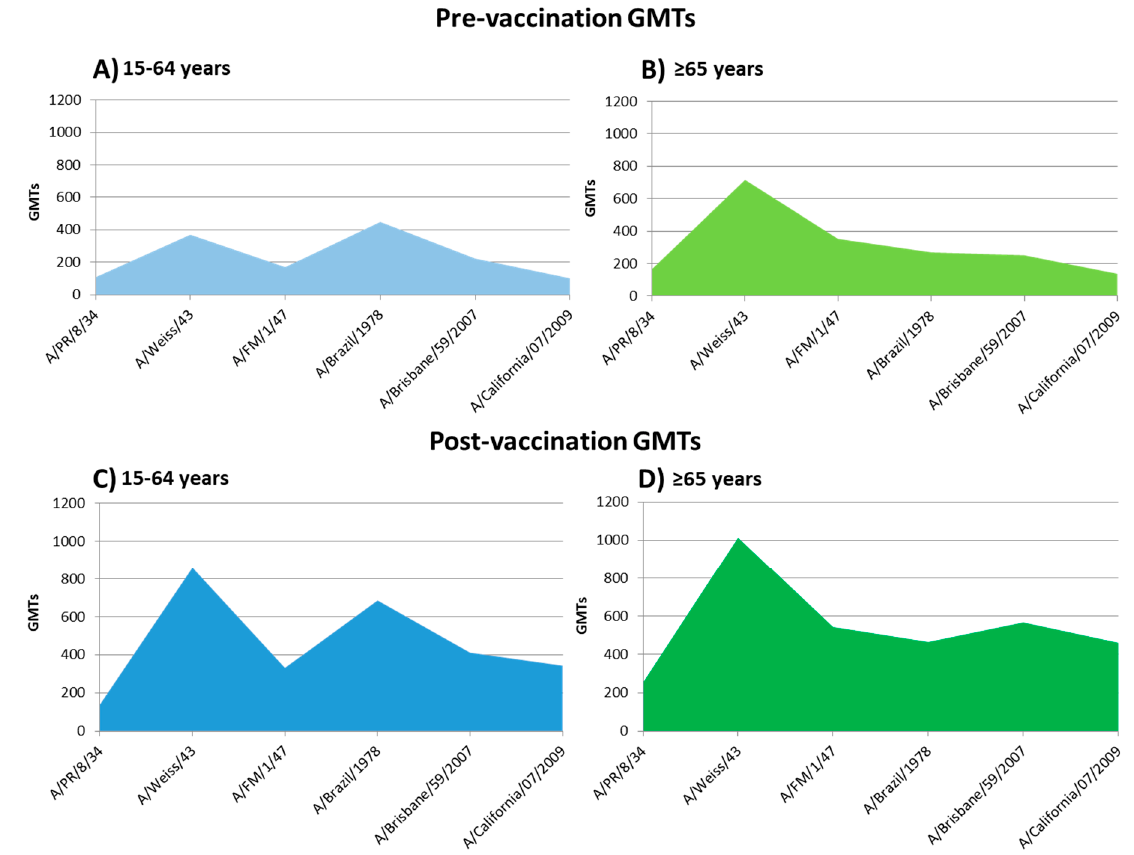
Figure 3. Profile of pre-vaccine GMTs and its increase after seasonal influenza vaccination. ( A ): pre-vaccine GMTs of 15–64 years group; ( B ): pre-vaccine GMTs of the elderly group; ( C ): post-vaccine GMTs of 15–64 years group; ( D ): post-vaccine GMTs of the elderly group.